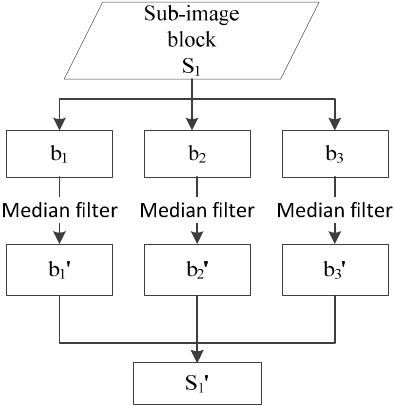
Figure 4. Example of each band of a sub-image block (S 1 ) filtered using a median filter.